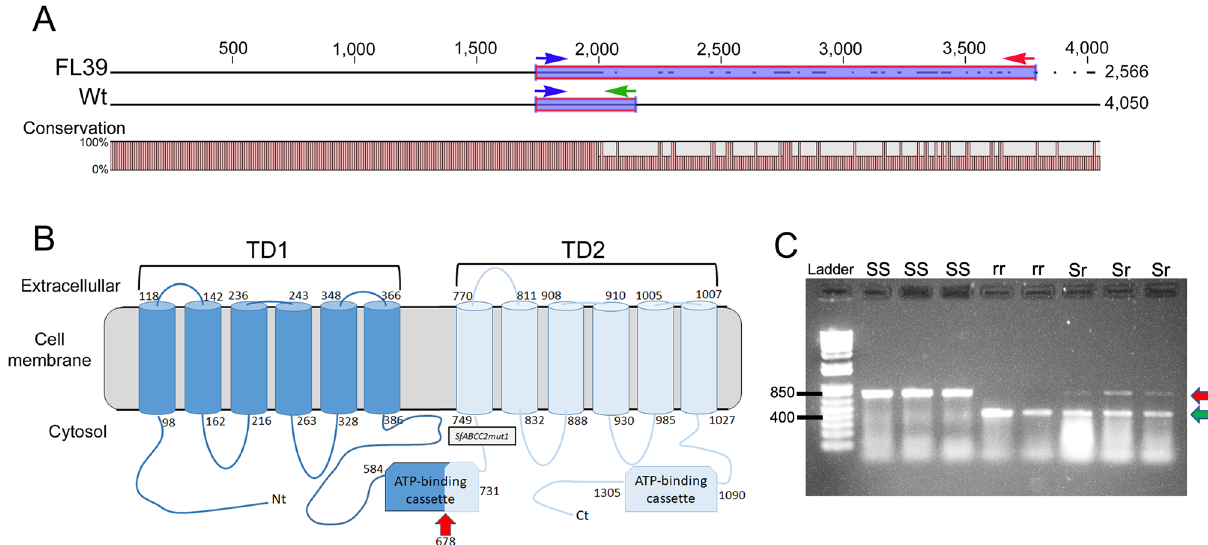
Figure 1. Comparison of the transcript and SfABCC2 protein in susceptible and Cry1F-resistant strains of S. frugiperda , and development of a discriminatory PCR reaction detecting the aberrant transcript in resistant larvae. ( A ) Alignment of the aberrant complementary DNA (cDNA) encoding the SfABCC2 protein amplified from midguts of the Cry1F-resistant FL39 strain (GenBank accession number OL791323) compared to the wild type (Wt) cDNA from a susceptible strain (Benzon, GenBank accession number KY489760) of S. frugiperda . Arrows indicate priming sites for a common forward (blue) primer and reverse primers specific to the Wt (green) or aberrant cDNA (red) used in a discriminative PCR reaction. ( B ) Diagram representing the predicted topology of the SfABCC2 protein in the cell membrane. Red arrow indicates location (amino acid residue) of predicted truncation in the aberrant SfABCC2 protein in strain FL39. Light blue coloring of the structure represents the region of the SfABCC2 protein that is predicted not to be produced in FL39 larvae. The truncation occurring in allele SfABCC2mut from Puerto Rico is indicated with a box. Numbers represent amino acid residues at the start of loops; TD = transmembrane domain. ( C ) Results from a discriminative PCR reaction with primers in ( A ) and cDNA from individual larvae. Shown on the left are molecular size marker positions for 400 and 850 bp. Amplicons of different size were detected for the aberrant SfABCC2 cDNA in strain FL39 (r, 767 bp, red arrow) and the wild type SfABCC2 cDNA (S, 411 bp, green arrow). Genotype (SS, Sr or rr) predicted from the observed amplicons is shown above each